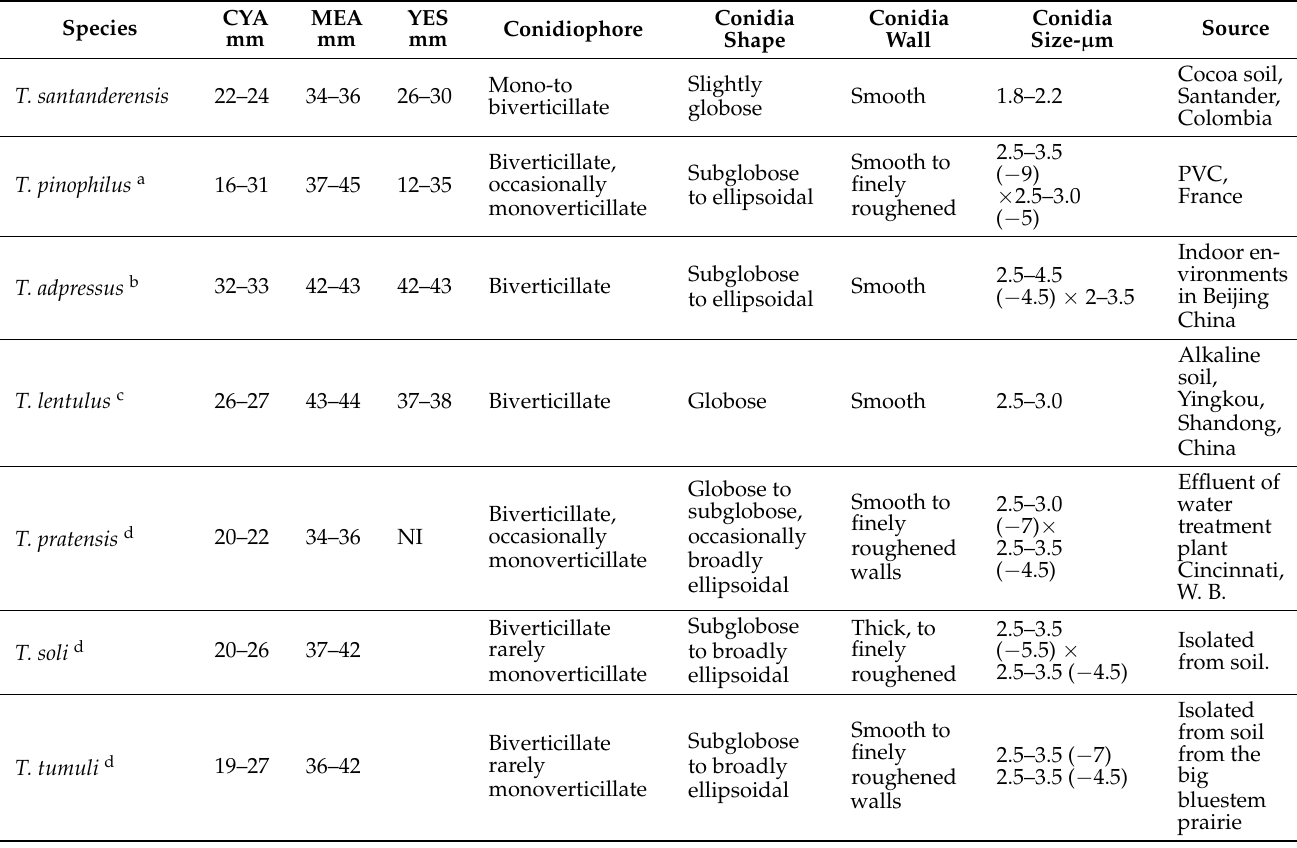
Table 2. The morphological comparisons of new Talaromyces species and their closely related